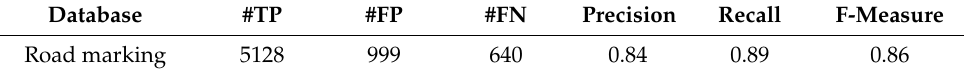
Table 6. Experimental results by our method with the Road Marking datasets.